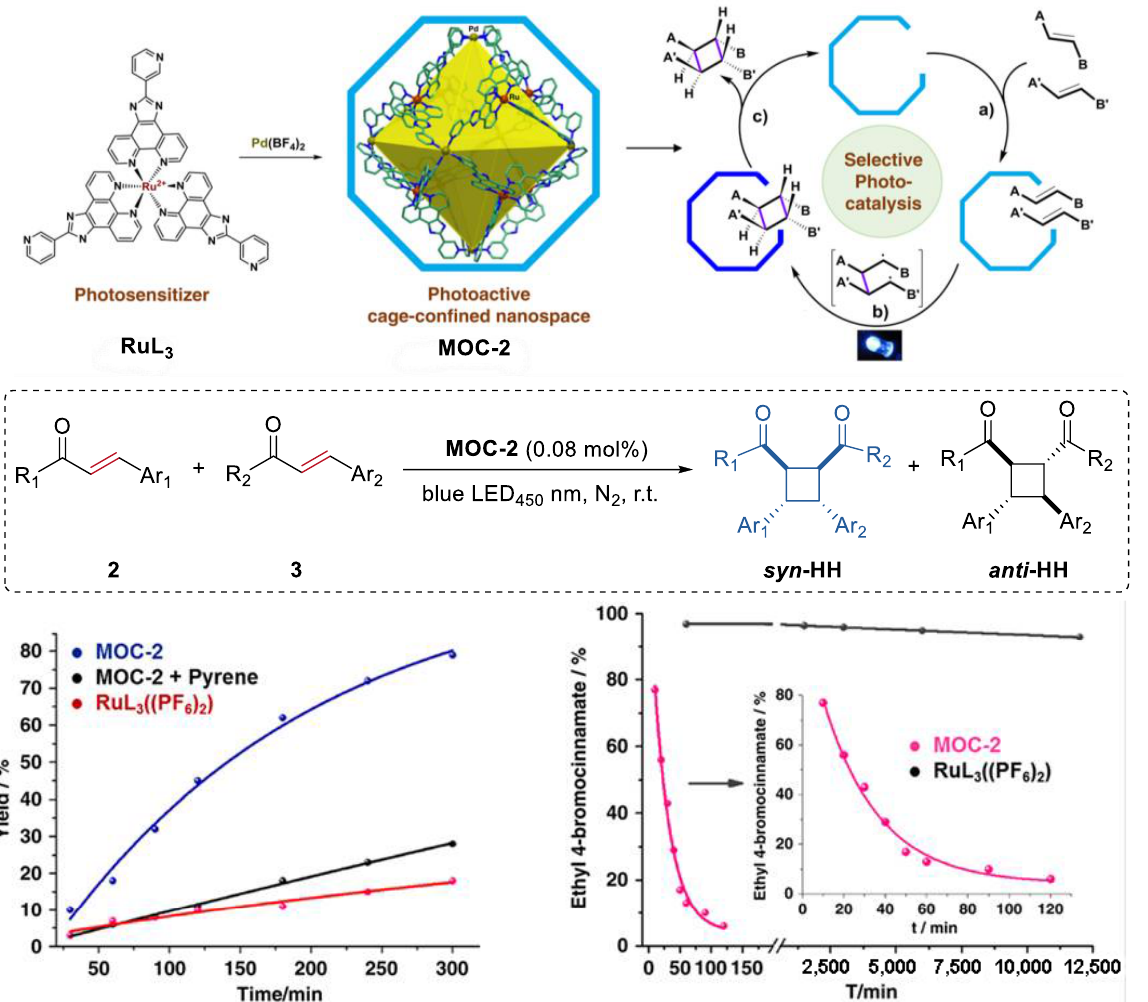
Figure 2. Intermolecular [2 + 2] cycloaddition of acyclic alkenes catalyzed by MOC-2 through visible-light triplet sensitization [45]. Reaction additions: 2 (0.10 mmol), 3 (0.10 mmol), MOC-2 (0.08 mol%) or 0.64 mol% RuL 3 (PF 6 ) 2 , pyrene (10 eq.), DMSO and H 2 O, r.t. Reprinted/adapted with permission from Ref. [45]. Copyright 2014 American Chemical Society.